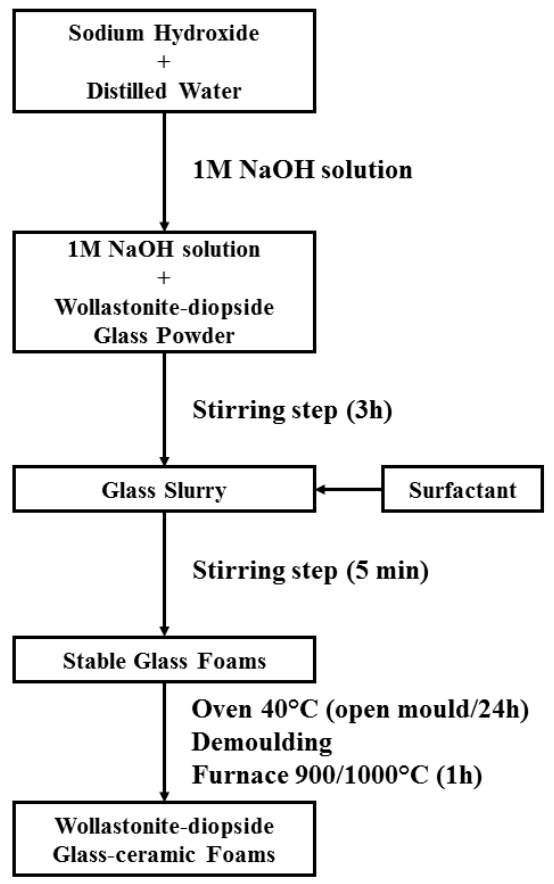
Figure 1. Flow chart of the W-D glass foams processing using the alkaline activation and gel casting.